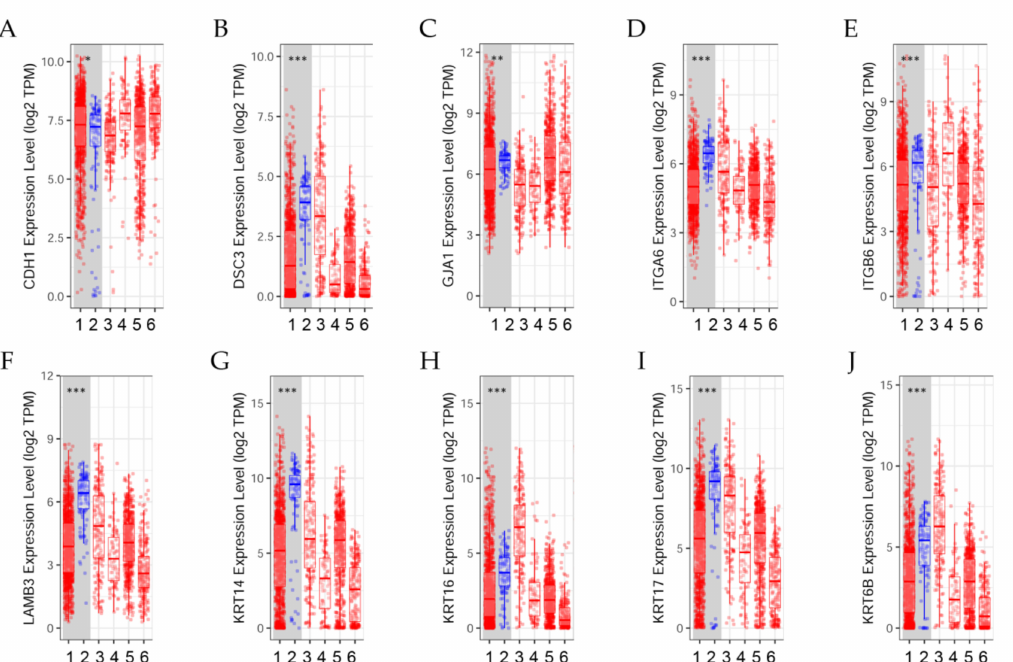
Figure 3. Differential gene expression levels between tumor and normal tissues across various cancer types. The box plots show the distribution of gene expression levels of ( A ) CDH1 , ( B ) DSC3 , ( C ) GJA1 , ( D ) ITGA6 , ( E ) ITGB6, ( F ) LAMB3 , ( G ) KRT14 , ( H ) KRT16 , ( I ) KRT17 , and ( J ) KRT6B in tumors versus normal tissues (Wilcoxon test, *: p < 0.05, **: p < 0.01; ***: p < 0.001) estimated by TIMER2.0 in breast invasive carcinoma [41]. (1) BRCA.Tumor ( n = 1093), (2) BRCA.Normal ( n = 112), (3) BRCA-Basal.Tumor ( n = 190), (4) BRCA-Her2.Tumor ( n = 82), (5) BRCA-LumA.Tumor ( n = 564), (6) BRCA-LumB.Tumor ( n =